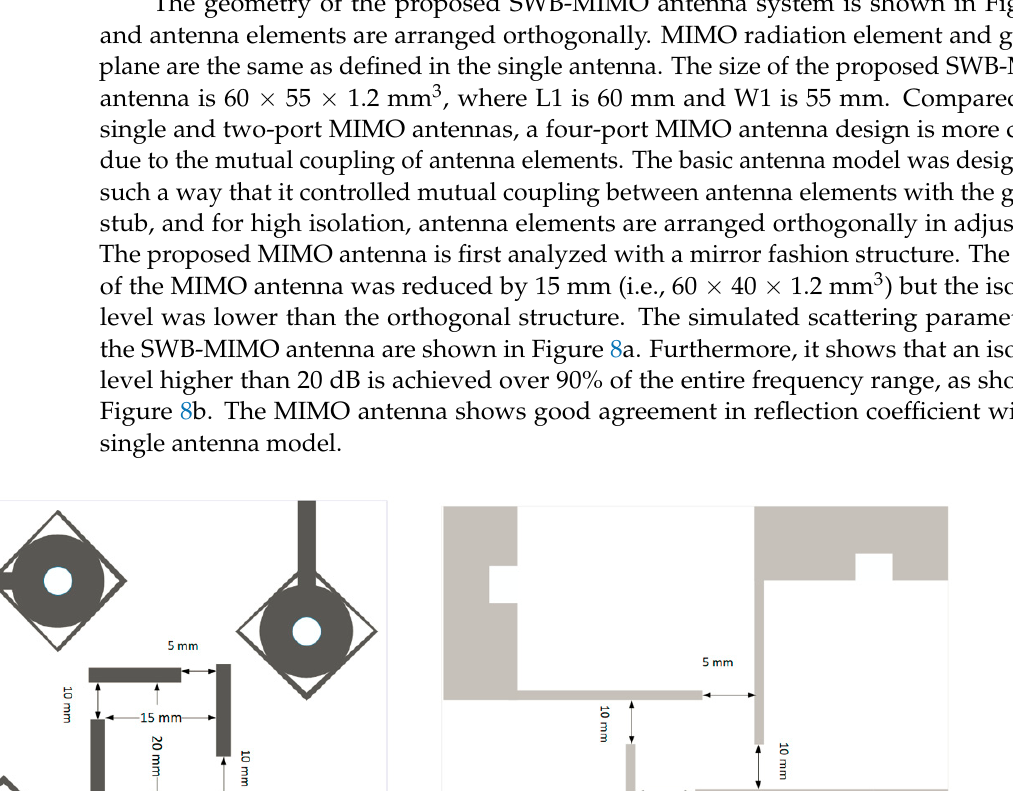
Figure 8. Simulation response of the orthogonal MIMO antenna. ( a ) S-parameters and ( b ) mutual coupling.